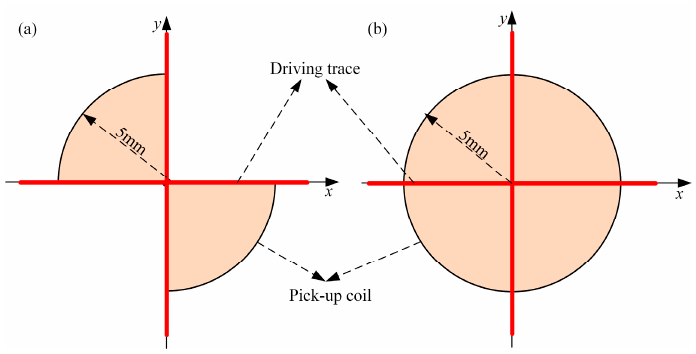
Figure 1. Two pickup coils for the two driver traces perpendicular to each other: ( a ) circular pickup coil, ( b ) two-circular sector pickup coil.